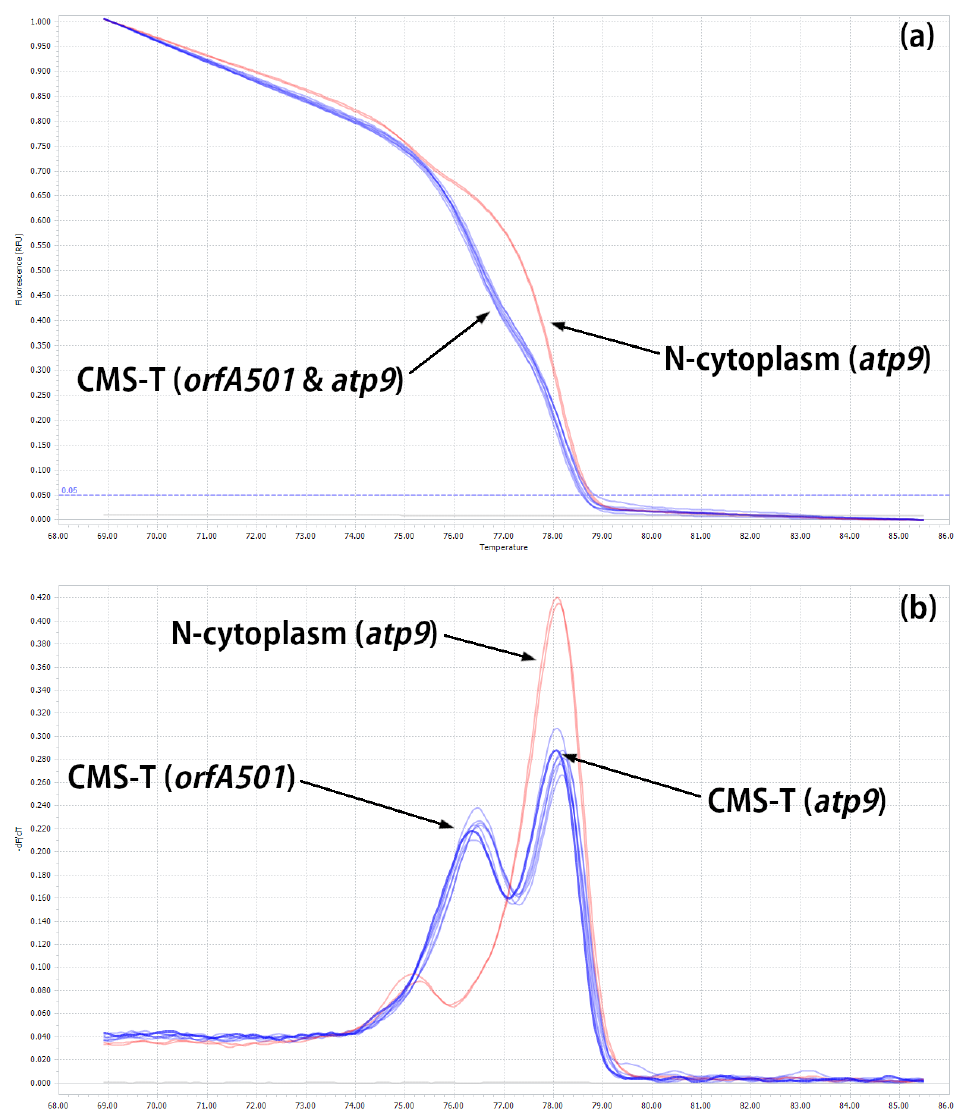
Figure 4. Differences between N- and T-cytoplasms detected using T-HRM primers based on orfA501 and atp9-HRM primers based on the atp9 gene (internal control): ( a ) normalized melting curve of amplicons and ( b ) normalized melting peaks of